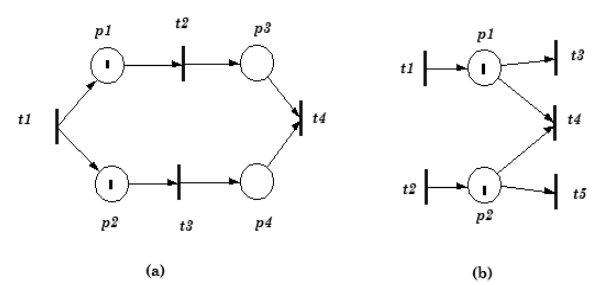
Fig. 4. Petri nets for representation of parallel activities (a) and symmetric confusion